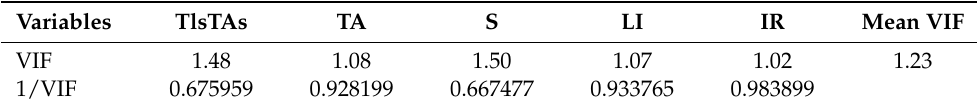
Table 7. VIF (Variance Inflation Factor) Results Obtained after Running TlsTAs on ROA and ROE OLS Model.